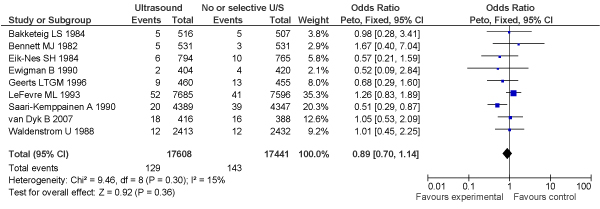
Forest plot of results of meta-analysis of perinatal mortality rates in women examined by routine vs. selective ultrasound in early pregnancy.